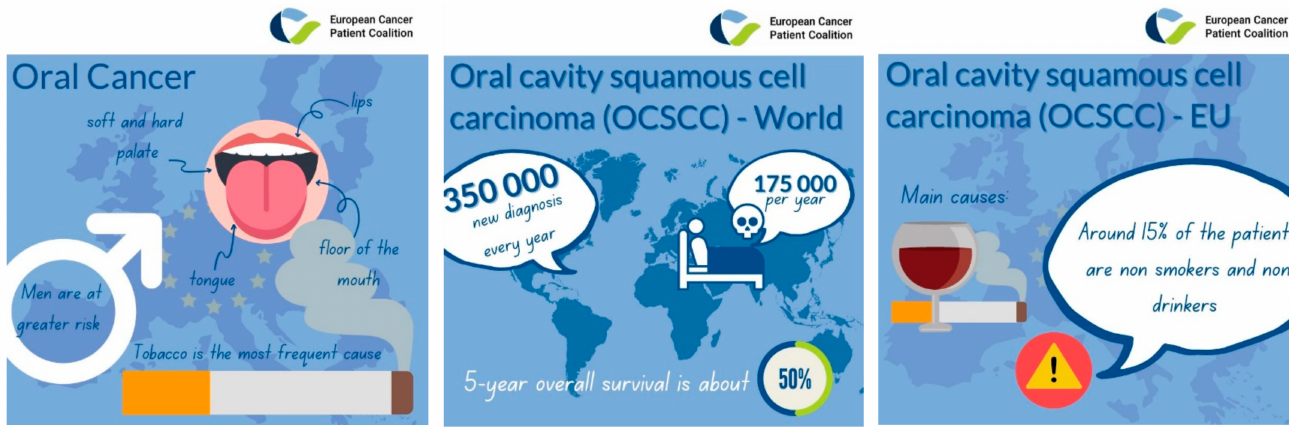
Figure 1. Oral cavity squamous cell carcinoma (OCSCC) incidence and main risk factors. 350,000 people are diagnosed with oral cavity squamous cell carcinoma (OCSCC) every year, and 175,000 patients die every year due to OCSCC. Tobacco is the most frequent cause, and only around 15% of the patients diagnosed with OCSCC in Europe are non-smokers and non-drinkers. Men are at greater risk than women, and the overall 5-year survival is about